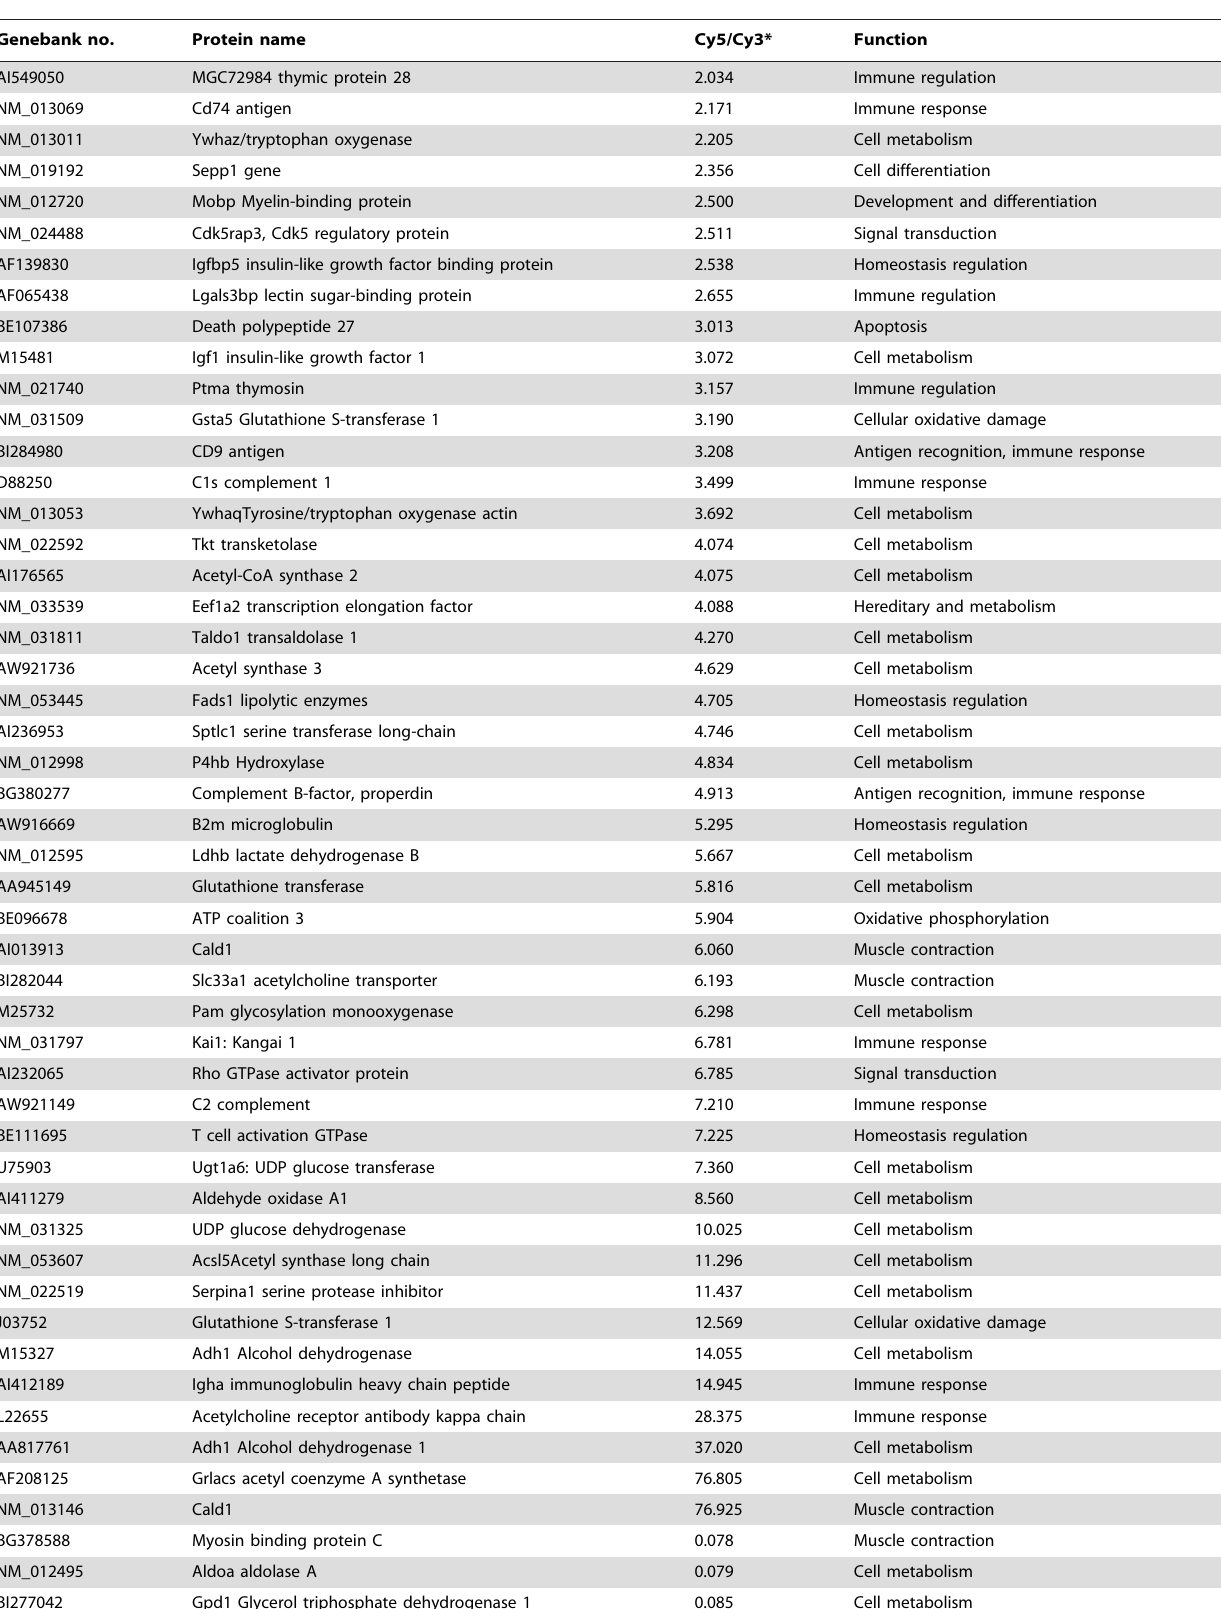
Table 4. Some differentially expressed genes between extraocular muscle and tibialis anterior muscle in control F344 rats.